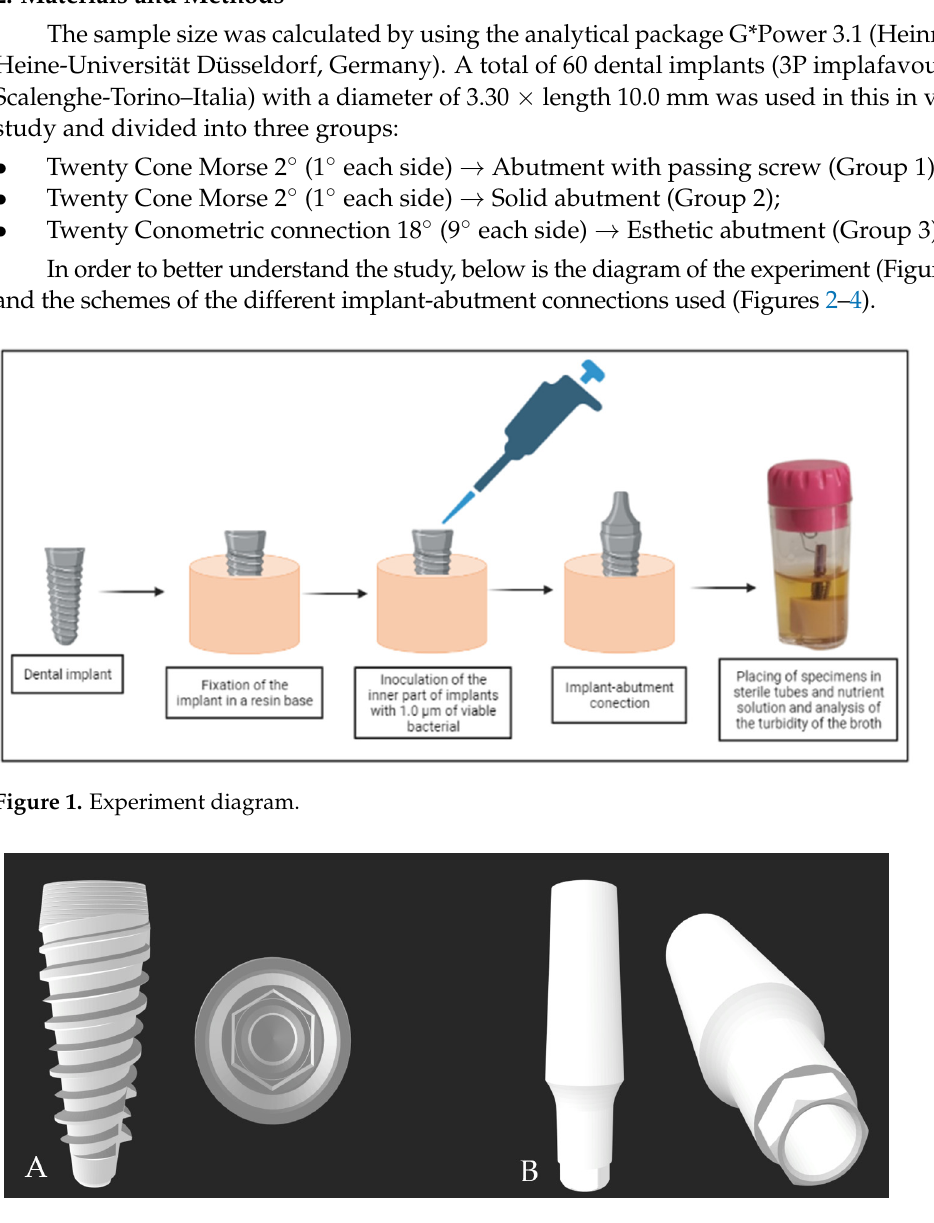
Figure 2. ( A ) Cone Morse 2 ◦ (1 ◦ each side); ( B ) Abutment with passing